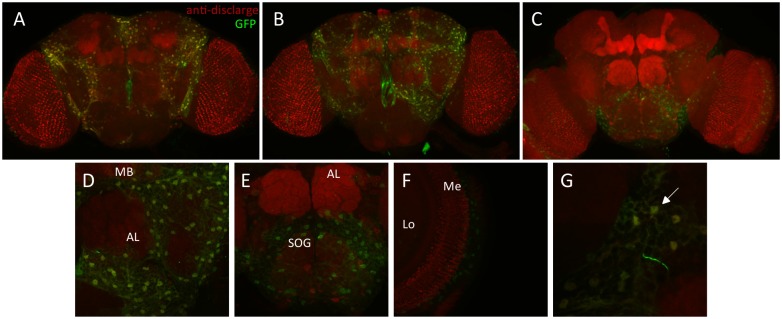
Expression of an MtnA-GFP reporter gene in the brain.(A-C) GFP expression driven by the reporter gene construct with the ancestral MtnA 3’ UTR variant. (D-G) Higher magnification of the brain regions where GFP is expressed. AL: antennal lobe, MB: mushroom bodies, SOG: subesophageal ganglion, Lo: lobula, Me: medulla. In (G) the arrow indicates cells expressing GFP. Green: GFP, red: anti-disclarge, targeting general neuropil.